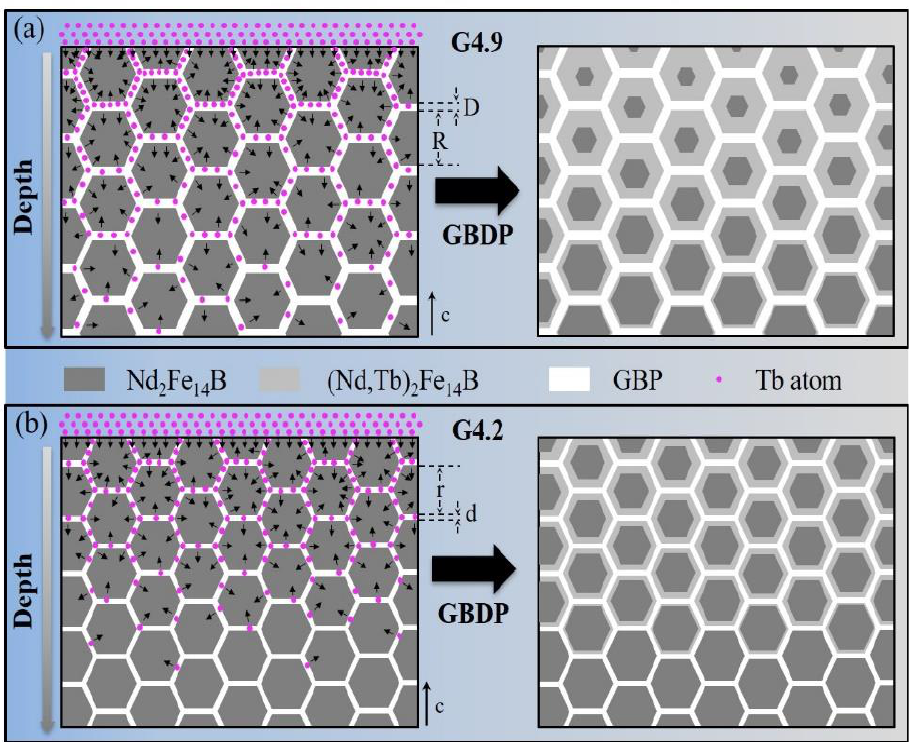
Figure 6. The schematic illustration of the diffusion process of the ( a ) G4.9 and ( b ) G4.2 magnets.